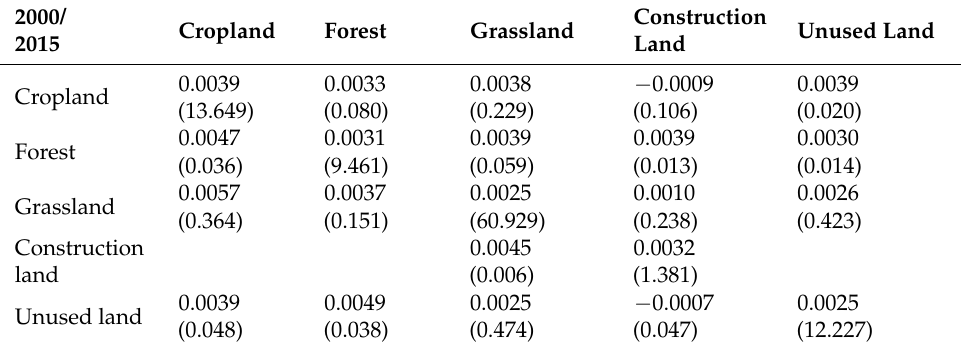
Table 3. Impacts of land use/cover change types on NDVI variations. The numbers in parentheses are the percentage of specific land use/cover change to the total area